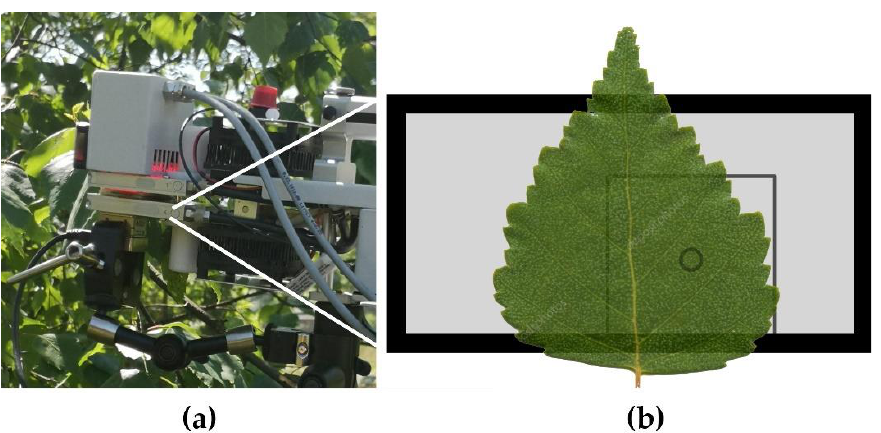
Figure 1. ( a ) Analysis of silver birch leaf water content using a leaf gas analyzer, fitted with a light module above and a miniature hyperspectral sensor (NIRONE 2.0) beneath; ( b ) schematic of miniature hyperspectral sensor analysis of silver birch leaf water content; open circle is the approximate sensor measurement area.